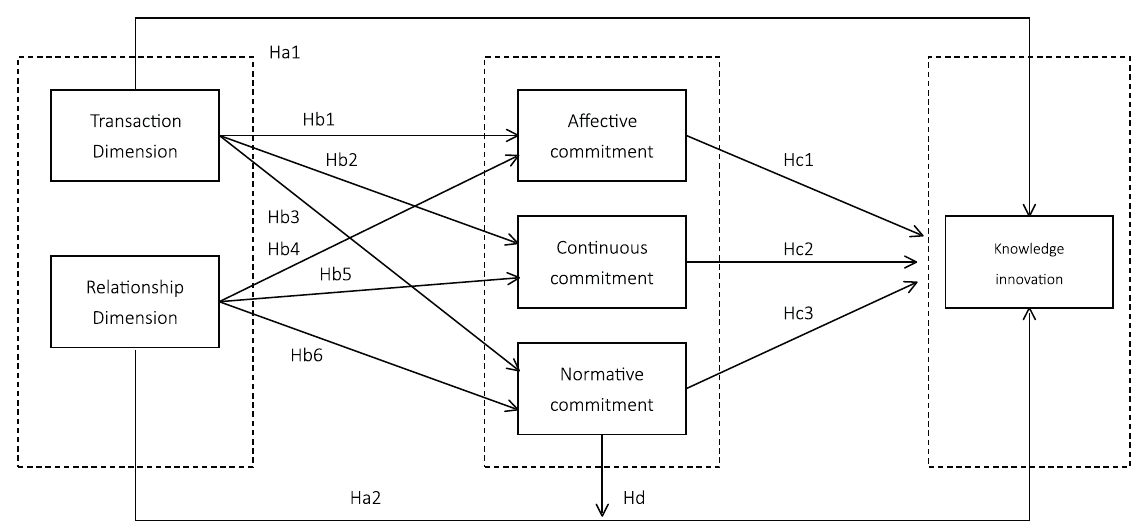
Figure 1. The conceptual